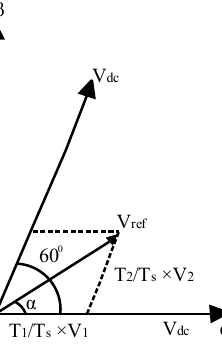
Figure 4. Vector representation of the SVPWM signal .